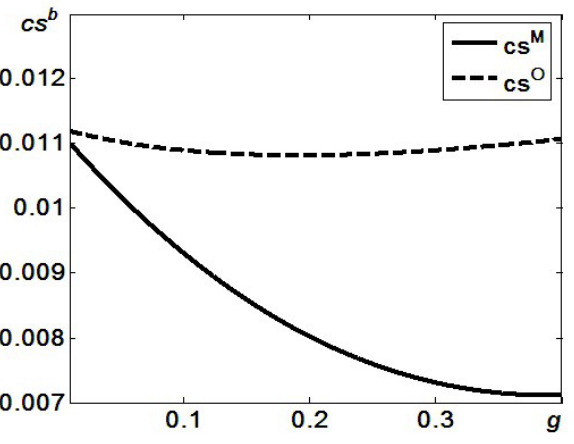
Figure 5. Effect of g on cs b